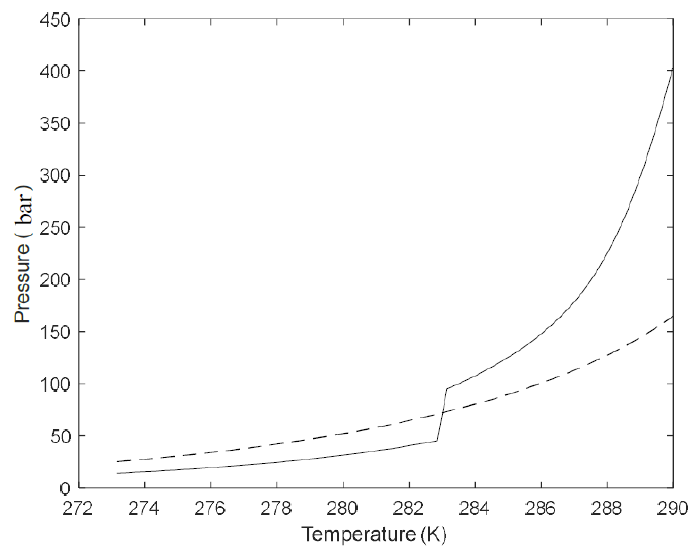
Figure 1. Hydrate stability region in the P-T projection of the stability regimes. The solid curve is for CO 2 , and the dashed curve is for CH 4 .